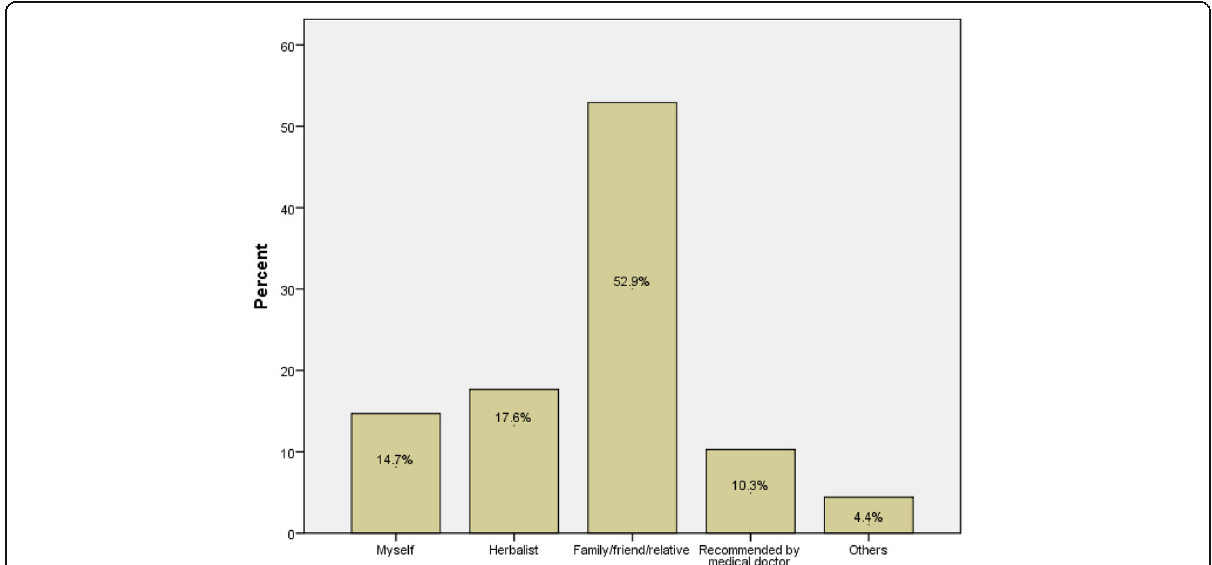
Fig. 3 Prescription source of herbal medicine during